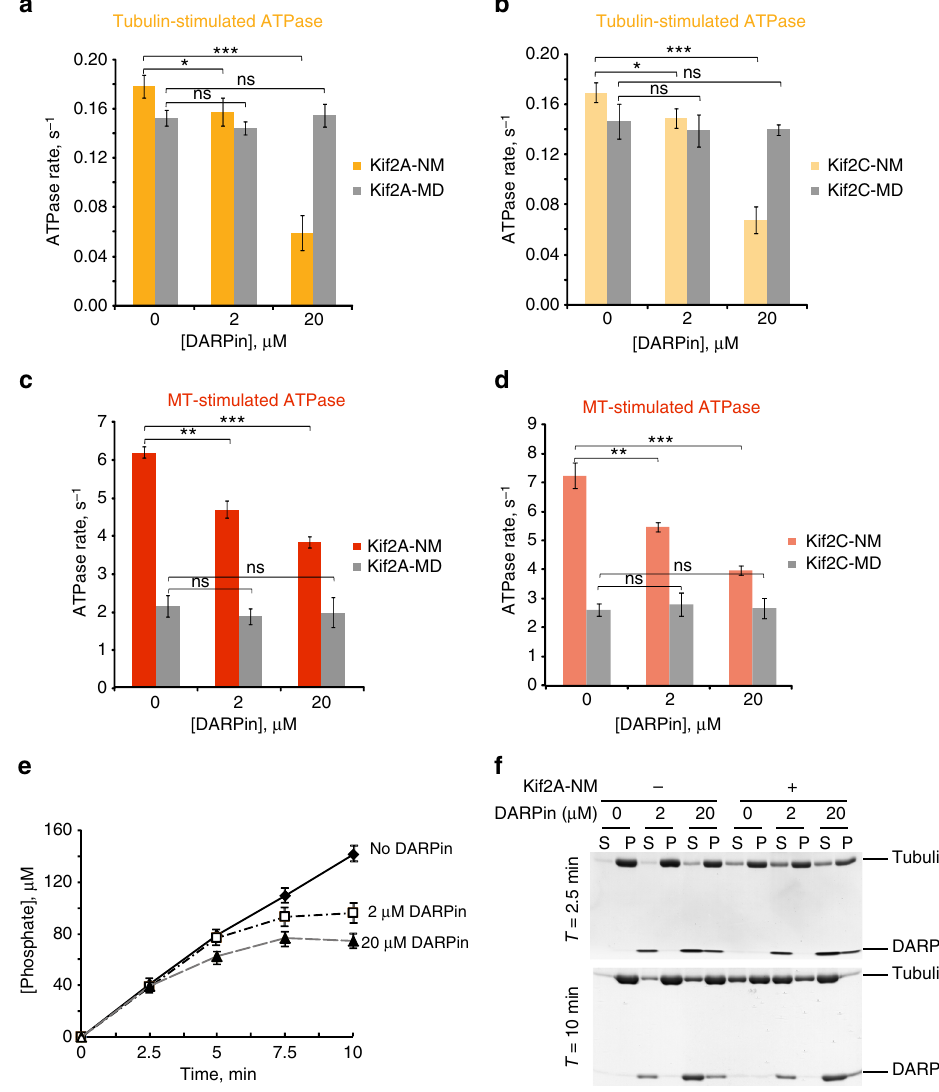
Fig. 6 MT-stimulated ATPase and MT-depolymerizing activities of kinesin-13s. a , b Effect of DARPin on tubulin-stimulated ATPase activity of kinesin-13 proteins. ATP turnover rates of Kif2A-NM (orange) and Kif2A-MD (gray) in the presence of tubulin with the indicated concentrations of DARPin are shown in a . Equivalent data for Kif2C-NM (light orange) and Kif2C-MD (gray) are shown in b . c , d Effects of DARPin on MT-stimulated ATPase activities of kinesin-13 proteins: c ATP turnover rates by Kif2A-NM (red) and Kif2A-MD (gray) in the presence of 2 µ M of taxol-stabilized MTs and the indicated concentrations of DARPin are shown. d Corresponding data sets of experiments for Kif2C-NM (light red) and Kif2C-MD (gray) as shown. Data from a and b represent averages from at least four independent experiments. Error bars, S.D.; ns: p > 0.05; * p ≤ 0.05; ** p ≤ 0.01; *** p ≤ 0.001, by Student ’ s t -test. e Time course plots of inorganic phosphate release by Kif2A-NM under the same experimental conditions as in c . Averages from N = 3. Error bars, S.D. f Monitoring of MT polymers present at the 2.5 and 10-min time points of the experiment shown in c (right three pairs) and the corresponding controls without Kif2A-NM (left three pairs) by a centrifugation-based sedimentation assay. S supernatant fraction; P pellet fraction. Samples were resolved by SDS-PAGE and gels were stained with Coomassie blue. Representative gels are